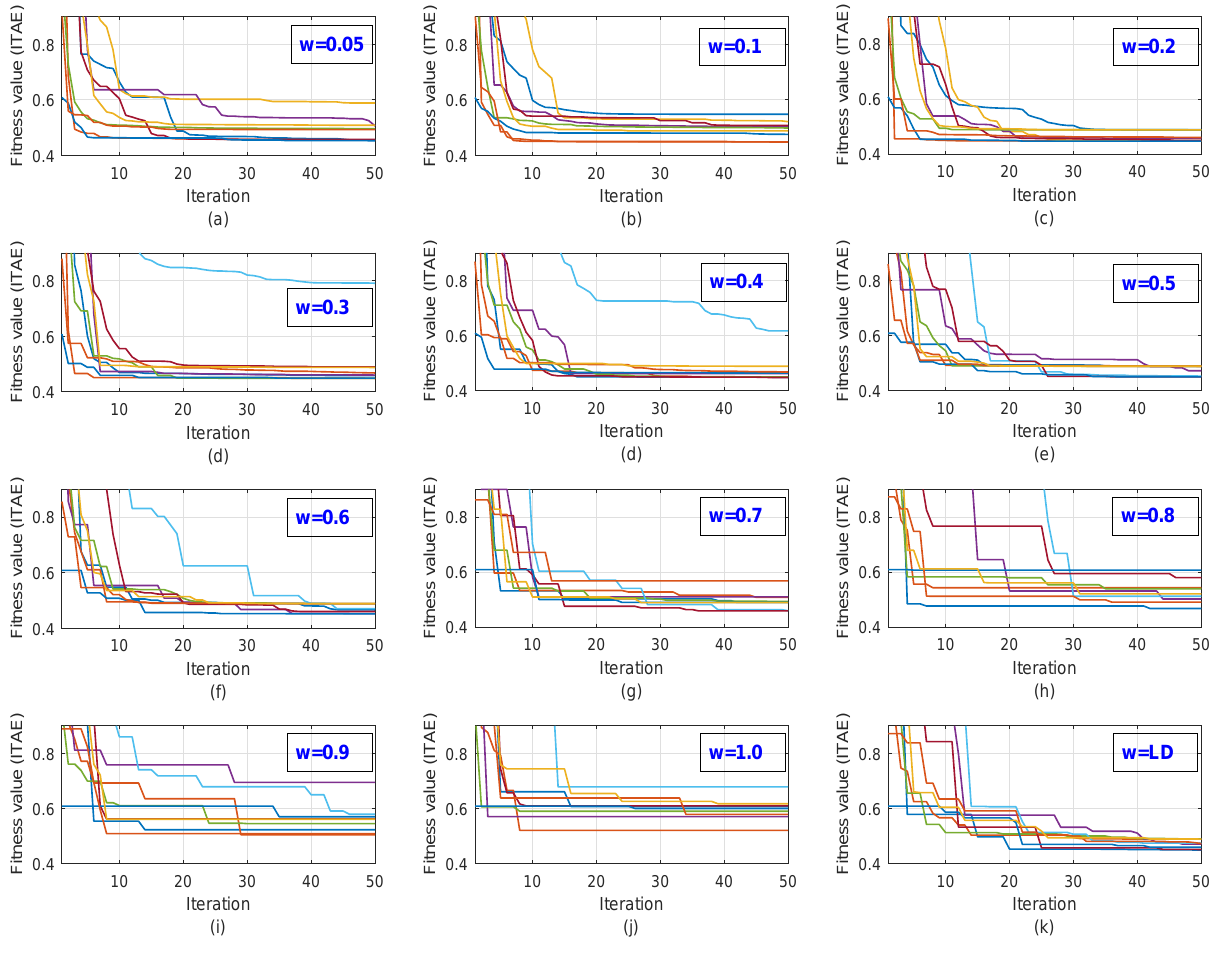
Figure 3. Fitness values obtained with different inertia weight for 10 different trial: Inertia weight is 0.05, 0.1, 0.2, 0.3, 0.4, 0.5, 0.6, 0.7, 0.8, 0.9, 1.0 and LD (linearly decreased from 0.9 to 0.4) in (a), (b), (c), (d), (e), (f), (g), (h), (i), (j) and (k), respectively.